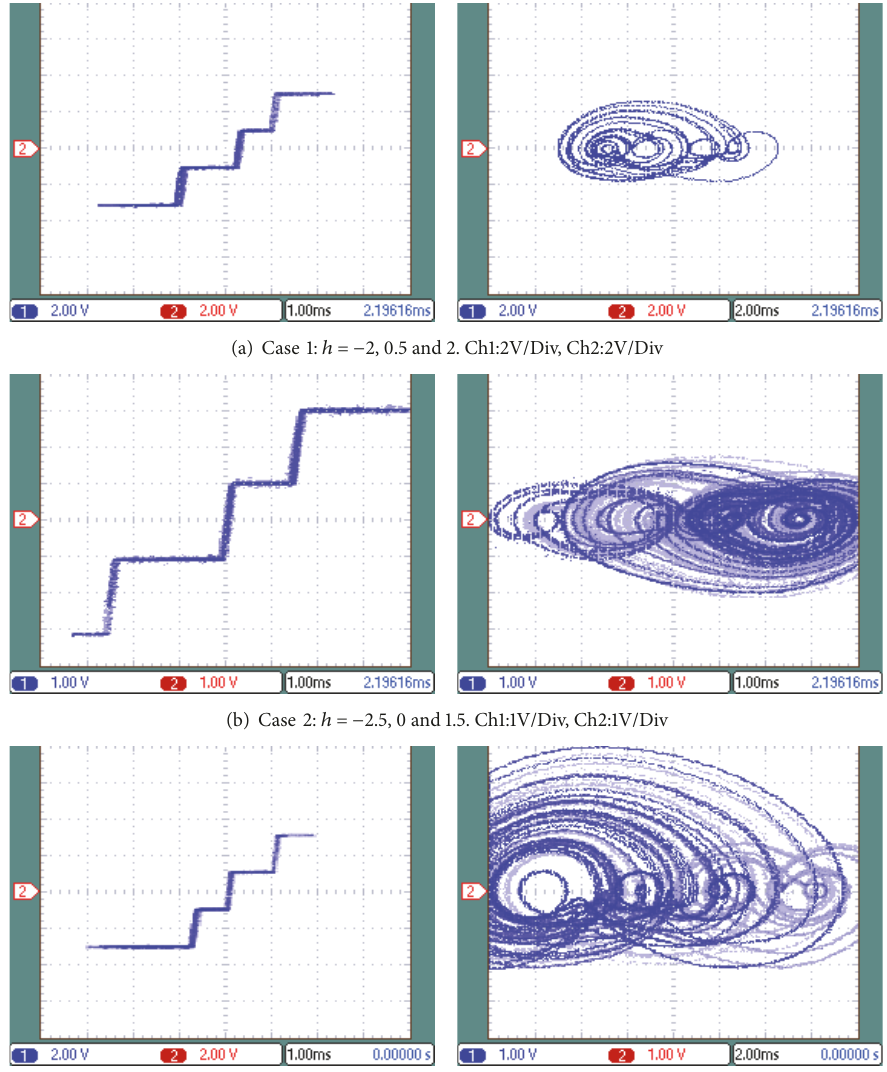
Figure 11: Experimental verification of optimized 4 scrolls using irregular SNLFs with different delays given in Table